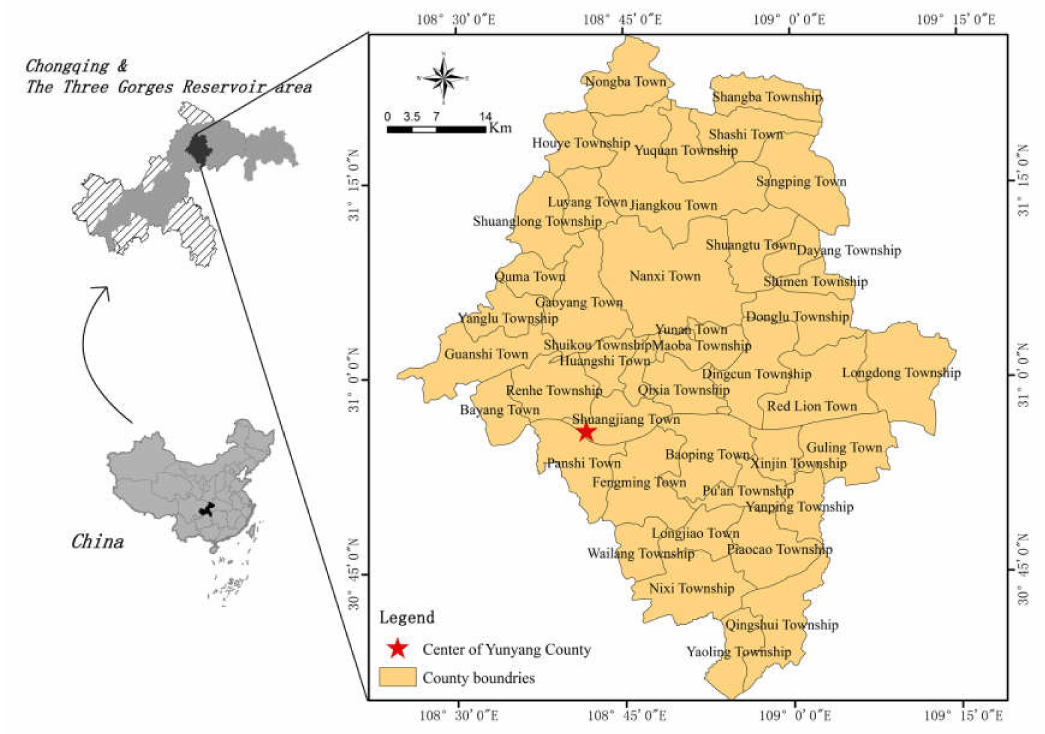
Figure 1. Location of the study